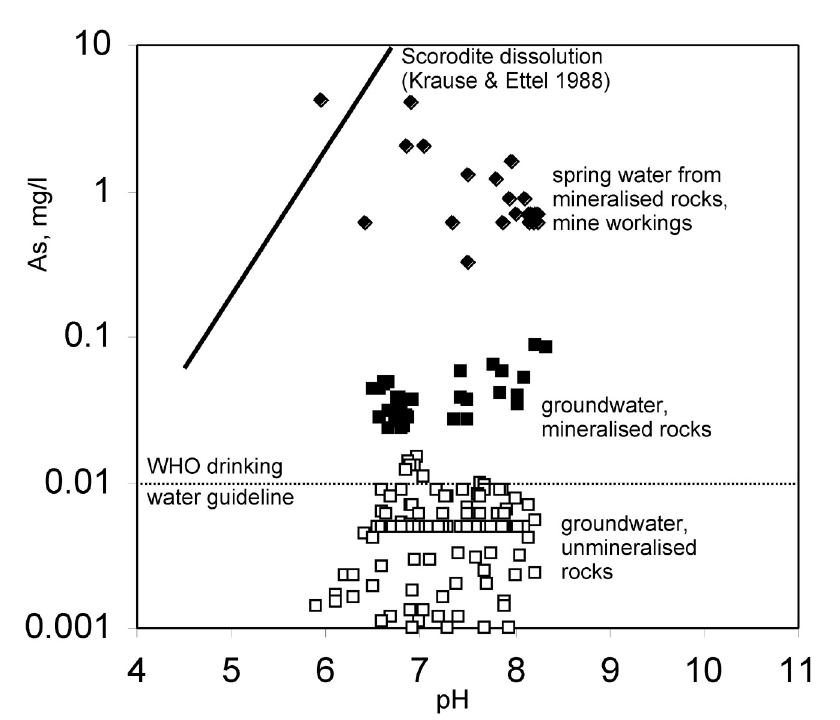
FIGURE 3. Dissolved As concentrations and pH of groundwaters in mineralised (arsenopyrite-bearing) and unmineralised rocks around historical mining areas in east Otago (Fig. 1), in relation to the World Health Organisation recommended drinking water guideline’s maximum value for As (dotted line). The row of data at 0.005 mg/l is due to the use of that detection limit for those samples. Maximum dissolved As concentrations resulting from dissolution of scorodite (after Karause and Ettel[21]) are shown with a solid